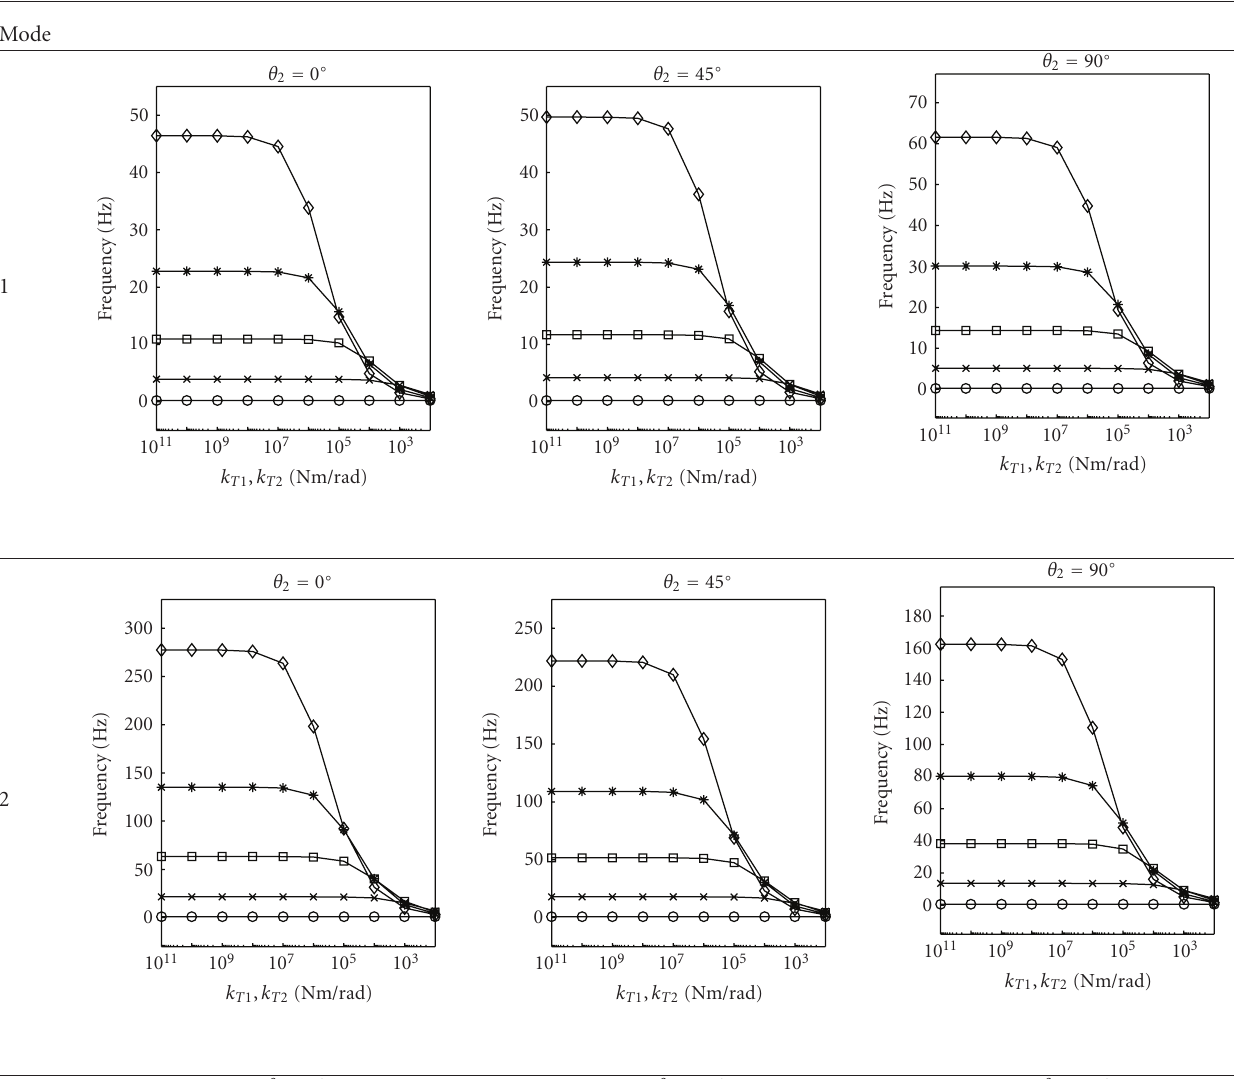
Table 7: Natural frequencies as a function of joint flexibilities † . Slenderness ratios: (cid:7) Table 2; × Table 3; (cid:2) Table 4; ∗ Table 5; ♦ Table 6.